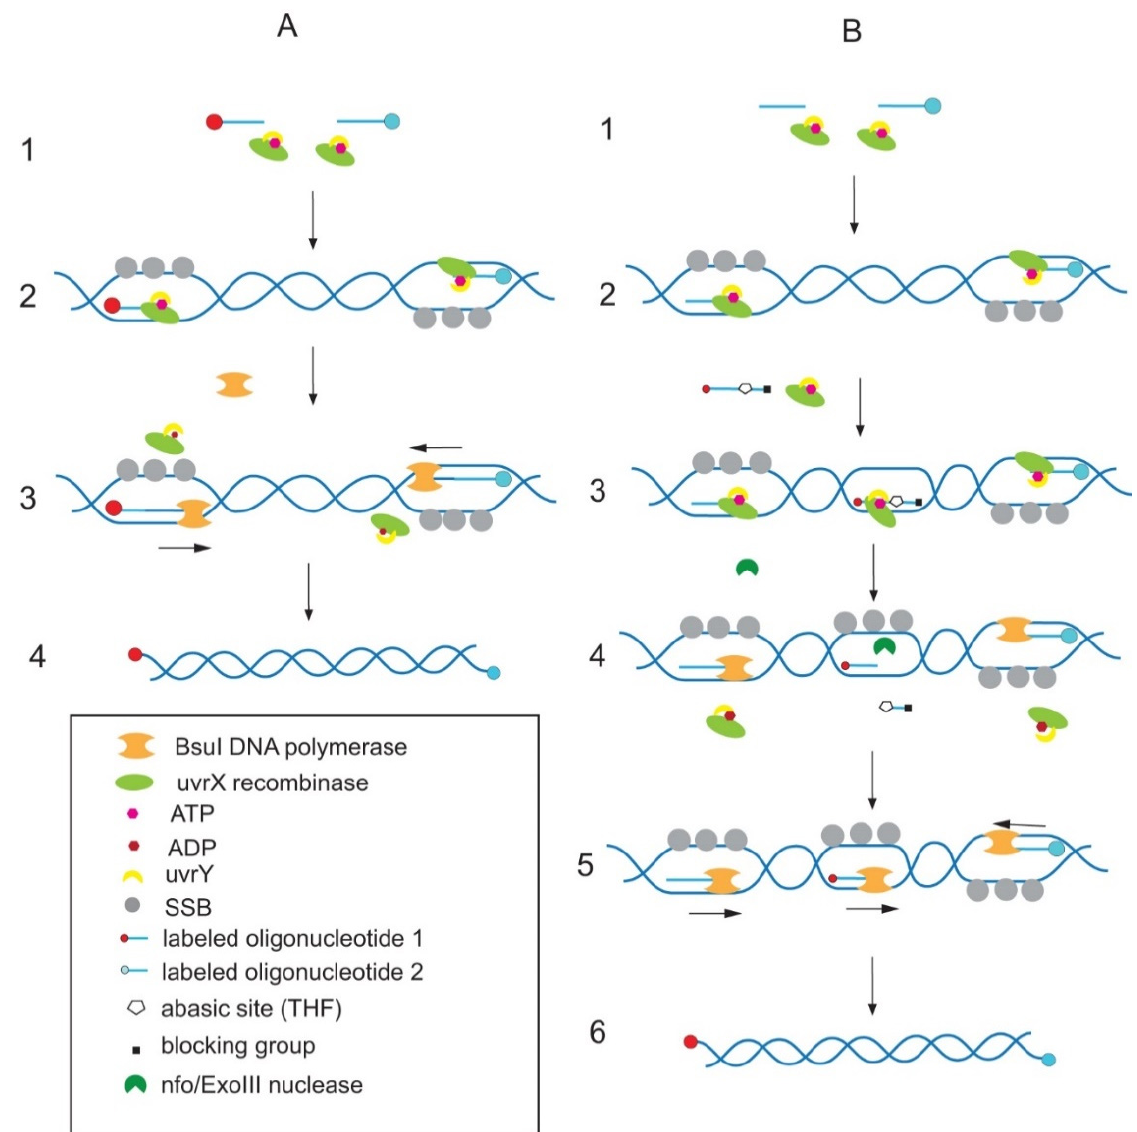
Figure 3. Scheme of recombinase polymerase amplification (RPA) A . Stages of basic RPA (TwistDx Basic): 1. Activation of primers by recombinase complex; 2. Recombinase-mediated primers annealing to target double-stranded (ds)DNA; 3. Recombinase complex dissociation and BsuI-dependent DNA polymerization; 4. Amplified DNA labelled by fluorescein (FAM) and biotin. B . Stages of RPA with probe (TwistDx nfo and TwistDx exo): 1. Activation of primers by recombinase complex; 2. Recombinase-mediated primers annealing to target dsDNA; 3. Activation of modified DNA probe by recombinase complex and recombinase-mediated probe annealing to target dsDNA between the primer annealing sites; 4. Dissociation of the recombinase complexes, start of polymerization from the primers, exonuclease III/nfo endonuclease